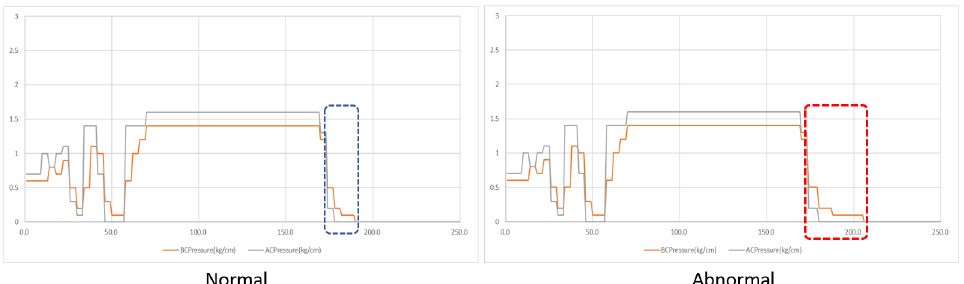
Figure 1. Normal and abnormal cases of the BOU